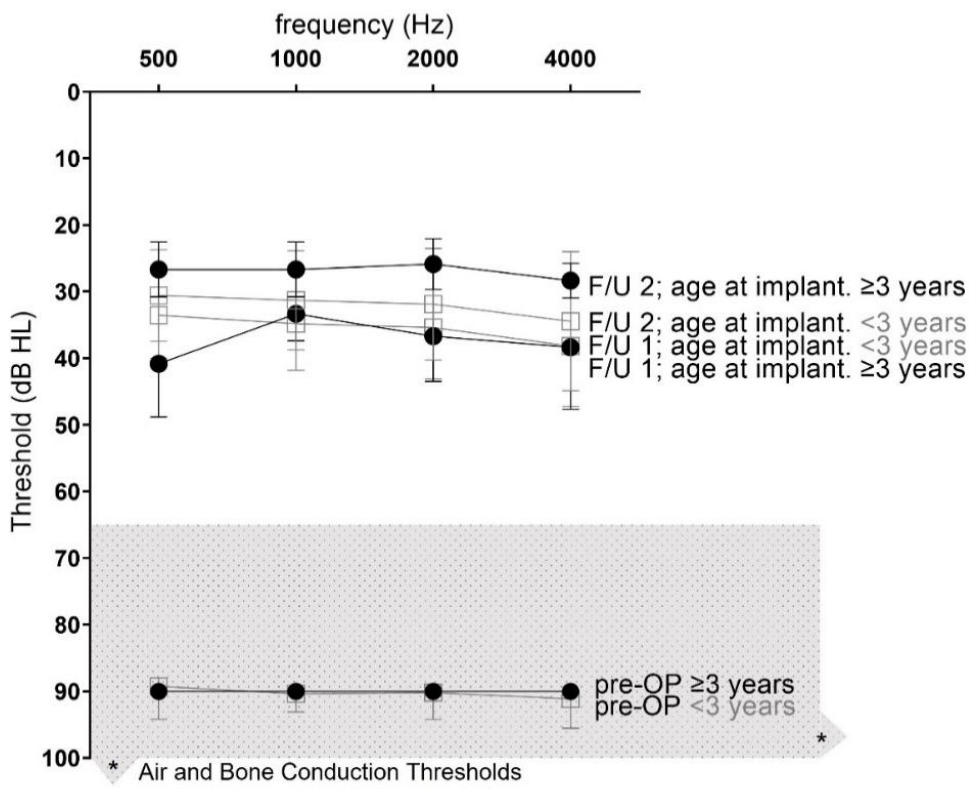
Figure 1. Soundfield audiometry. Displayed is the Soundfield audiometry showing the mean pre- and post-operative outcomes for two different follow-up (F/U) times: F/U1 (black dot): mean 1.30 ± 0.24 years; F/U2 (open square): 2.18 ± 1.31 years; separated regarding the age at implantation; full sign: age at implantation 3 years or older ( ≥ 3); open sign: age at implantation under 3 years of age (<3). The groups respective pre-operative values (unfilled symbols) are presented to show that subjects were within. The manufacturer’s indication limits are given as a light gray box, upper and lower indication limit in dB HL and * indicates upper limits in the x and y coordinates of up to 120 dB and up to 8 kHz.